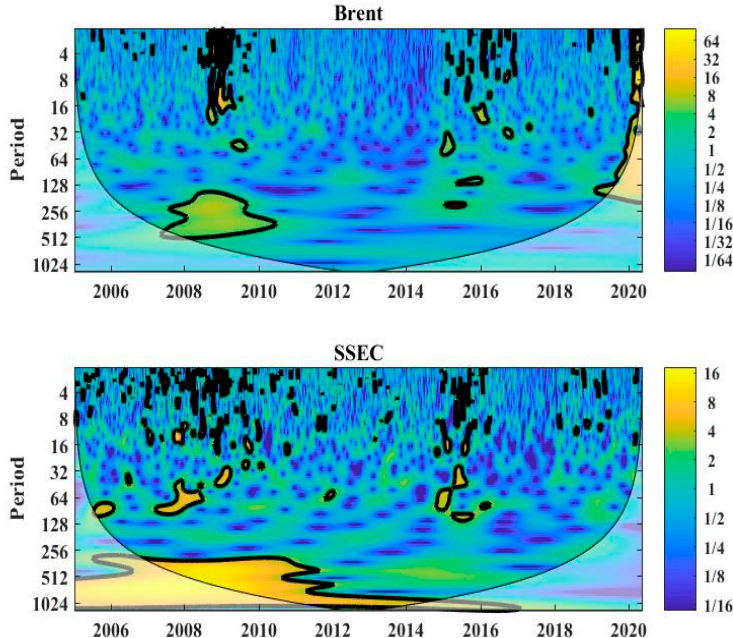
Figure 5. Continuous wavelet transform power spectra of Brent spot price and the Shanghai Composite Index.